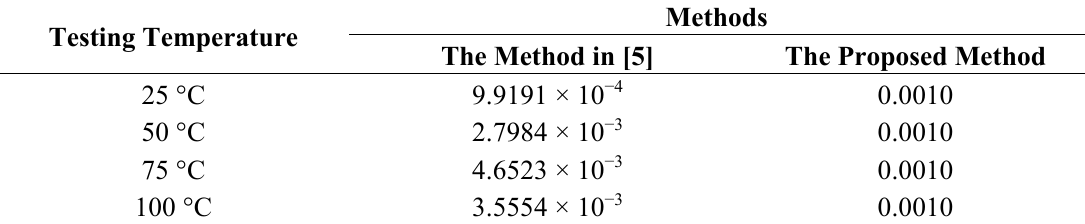
Table 8. Results obtained by different methods for the double diode model in nonstandard test conditions.